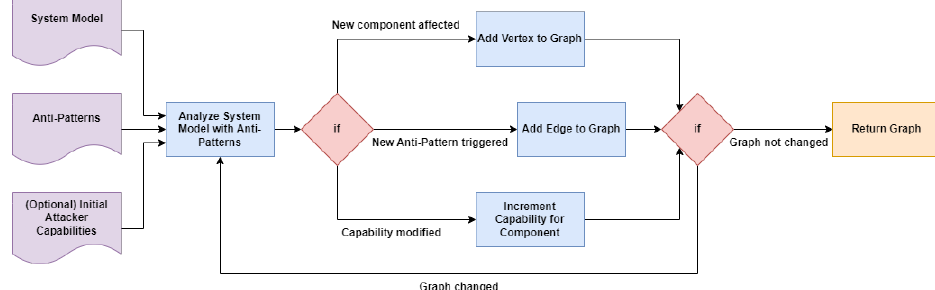
Figure 11. Attack graph generation